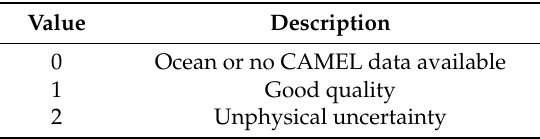
Table 2. Definition of CAMEL emissivity uncertainty quality flag.